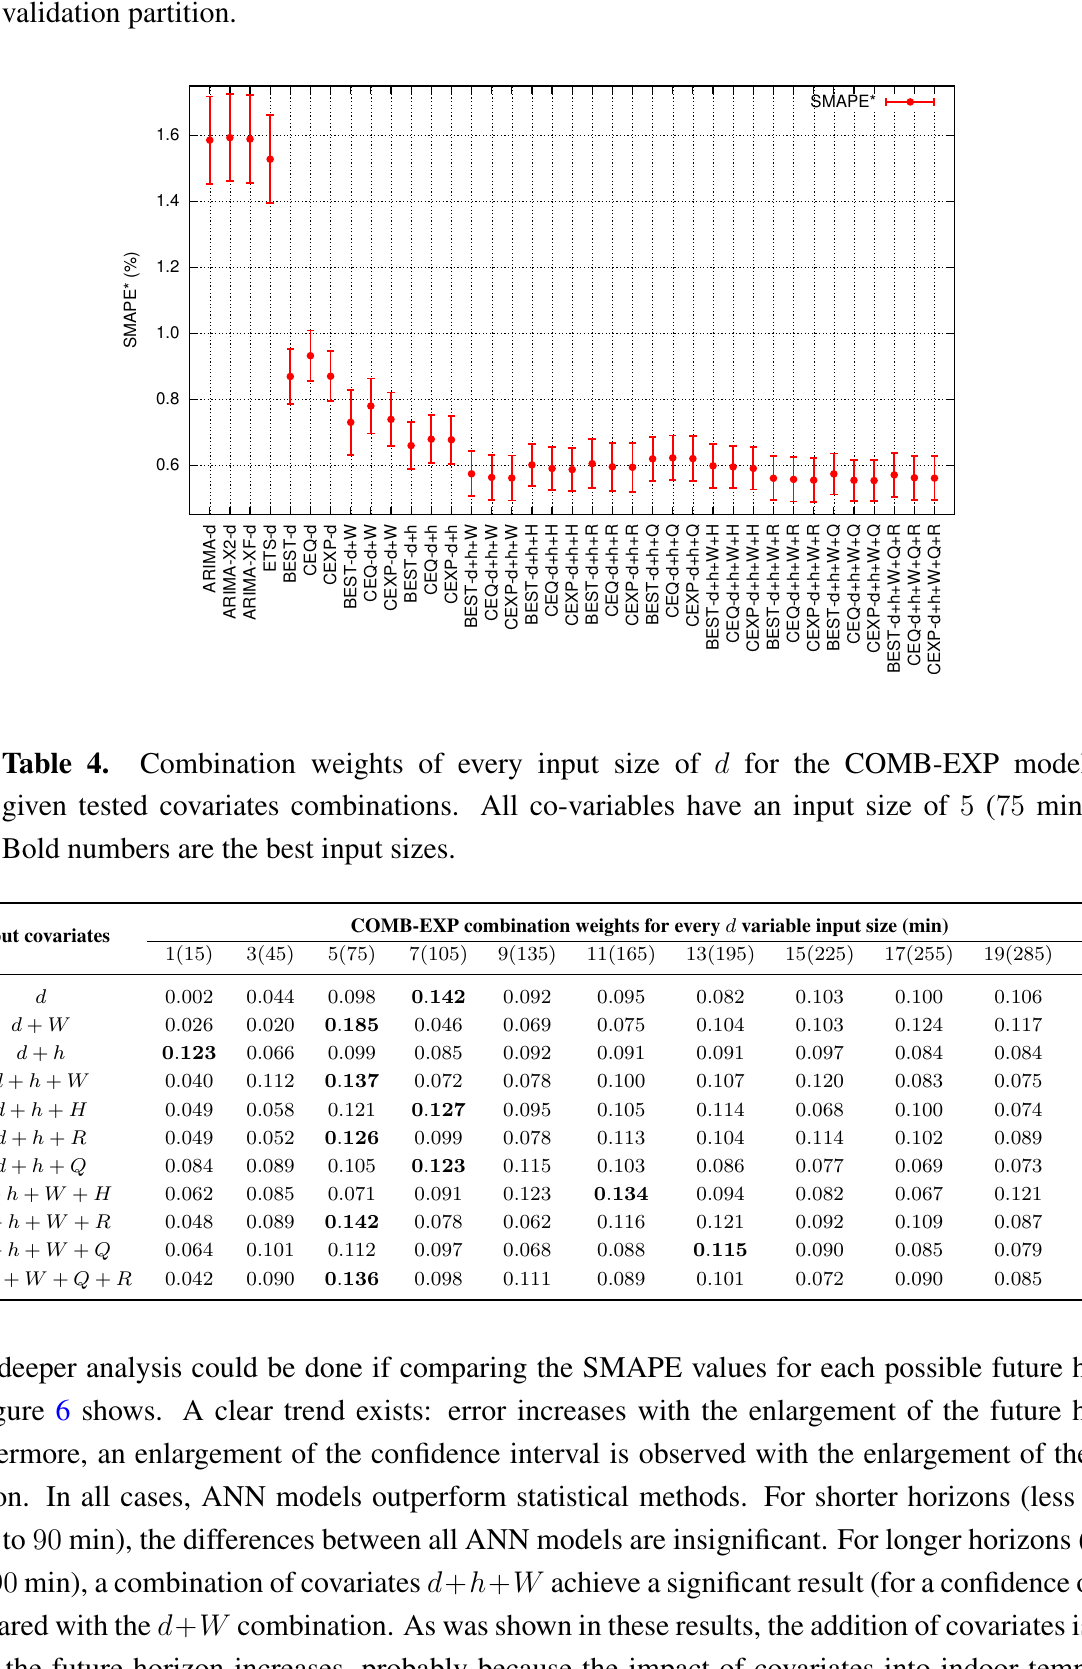
Figure 5. SMAPE (cid:63) error plot with 99% confidence interval for models of Table 3 on the validation partition.